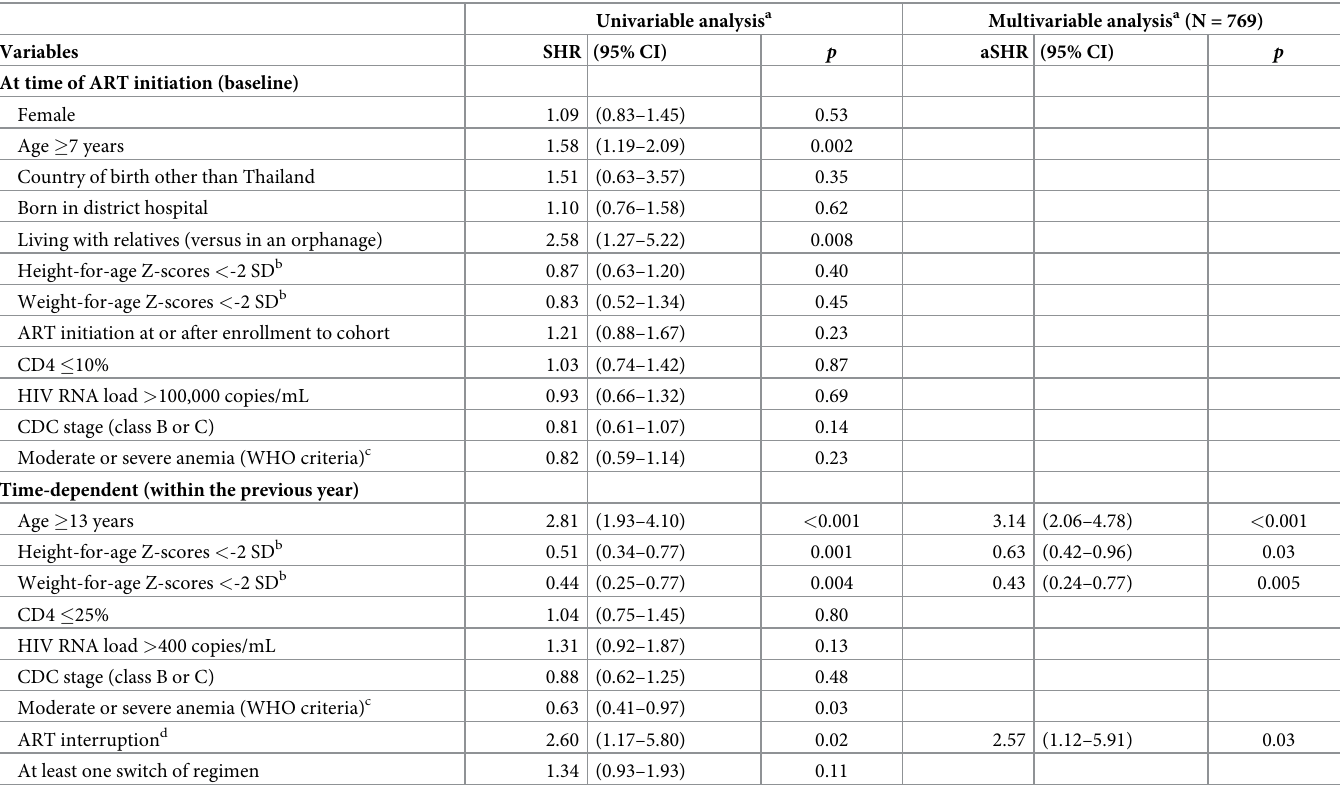
Table 2. Association between baseline and time-dependent characteristics and loss to